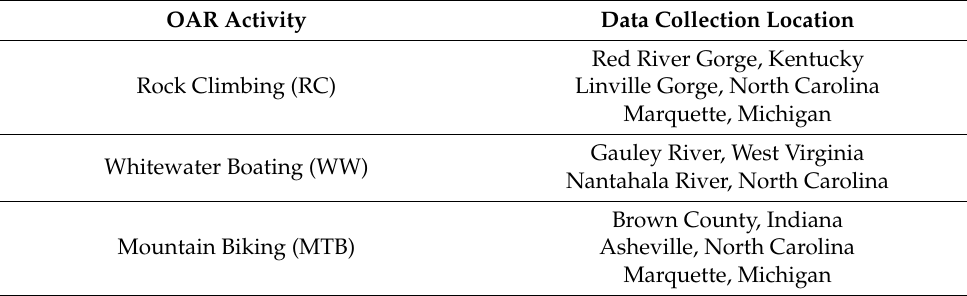
Table 2. Outdoor adventure recreation activity data collection